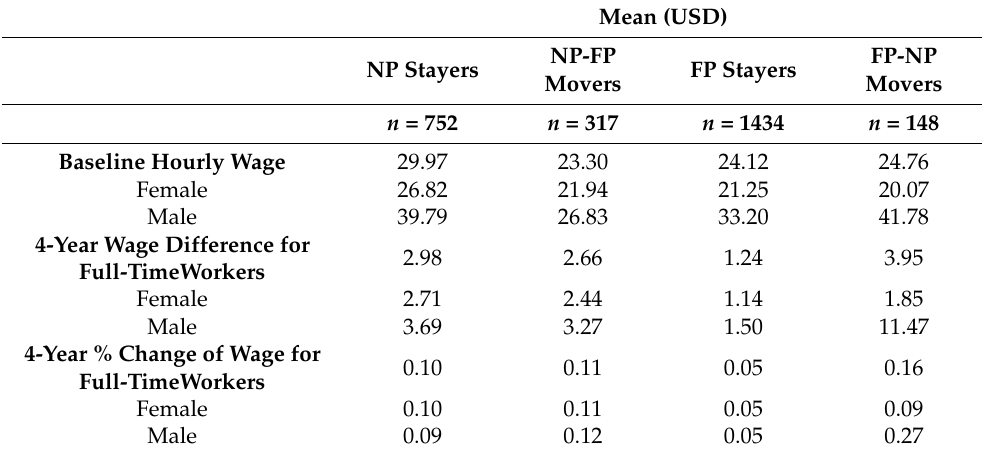
Table 4. Baseline wages and wage changes of the four